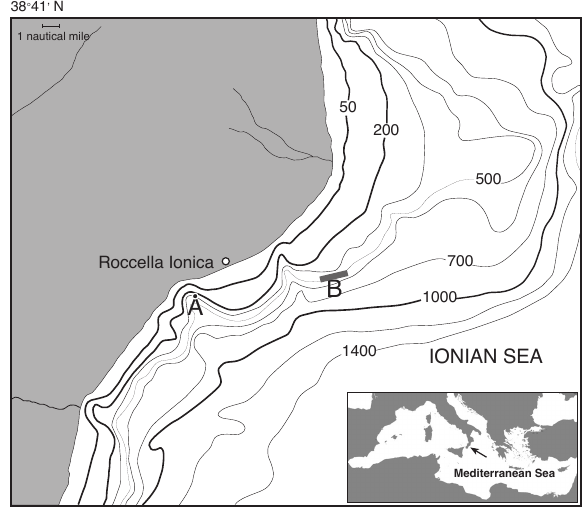
IG . 1 – Map of the study area in the Ionian Sea with indication of the releasing point (A) and the recapture area (B) of a tagged specimen of Aristeus antennatus